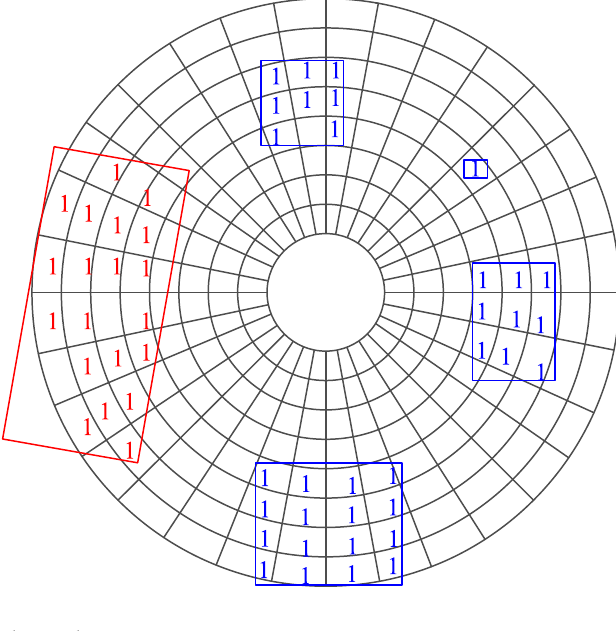
Figure 3. Constitution of neighborhood systems and labeling moving grids. The non-ground grids are clustered first to constitute the neighborhood system. If the size of a neighborhood system is larger than a pre-defined size, then it is labeled as a static system (marked by red in the figure). Otherwise, it is marked as a moving system (marked by blue in the